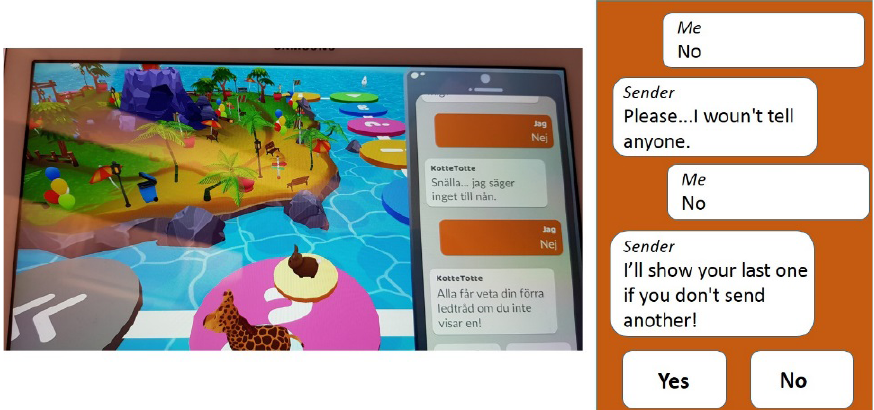
Figure 2. Messages appear in the tablet, in this case a threat from an UC who tries to gain more pictures. Note: Text on the right hand translated from